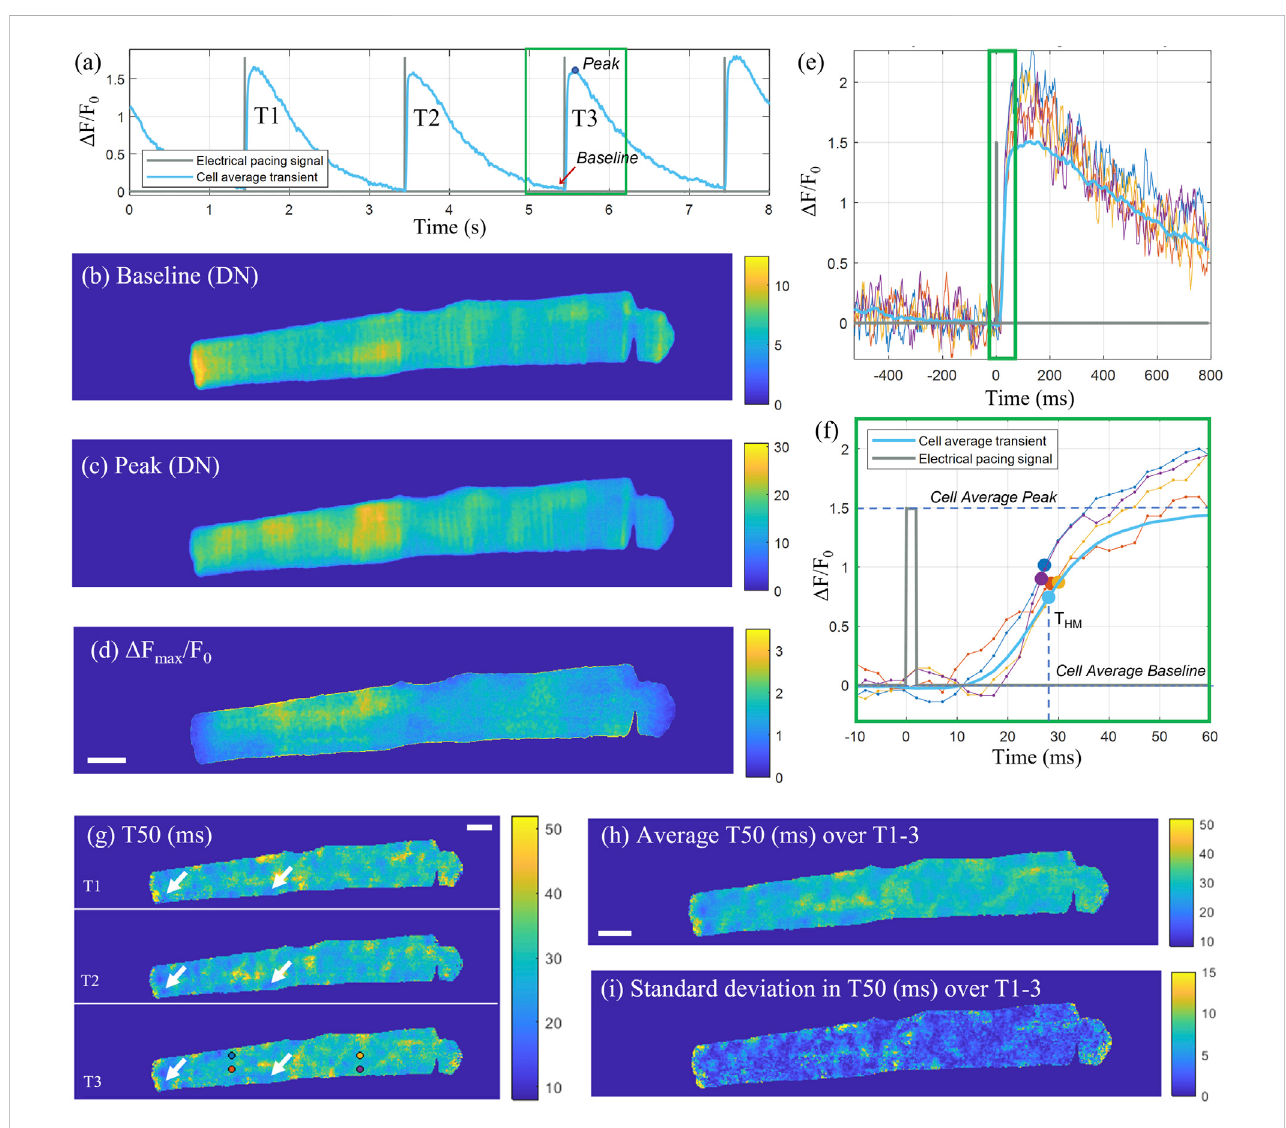
FIGURE 3 Pixel-wise determination of transient T50. (A) Cell average transient ( Δ F/F 0 ) for the example cell X as a function of time across the sampled time- sequence including three consecutive transients (T1, T2, T3). The recorded pacing signal at 0.5 Hz is shown in grey. For the third transient T3, cropped to a 525 frame (1.3 s) window (green rectangle), two-dimensional maps for the baseline fl uorescence (in digital numbers), peak intensity (in digital numbers) and Δ F F – D) respectively. (E) Intensity time traces through individual pixels indicated with circular markers in panel (G) for T3, and the max / o are shown in (B cell-averagetimetraceforT3. (F) Zoom-inontherisingedgeofthetransient[indicatedbythegreenrectanglein (E) ]withthe T HM timepointsfortheselected pixel traces indicatedwith markers. (G) T50 (ms) mapsfor thethreeconsecutive transients,withsomeexemplarrepeatingfeatures,correspondingto areasof early T50, indicated by white arrows. (H) Average T50 map (ms) and (I) standard deviation in T50 (ms) of the three transients. Scalebar: 10 μ